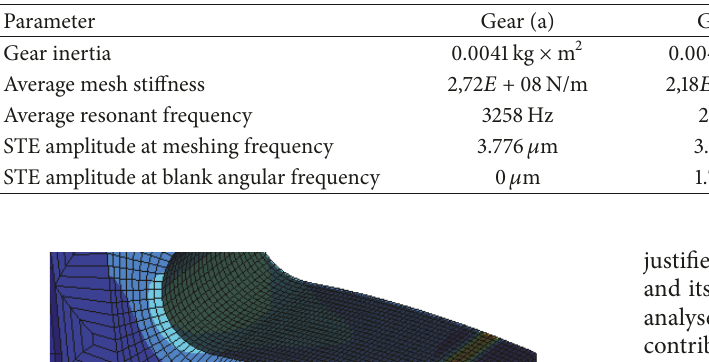
Table 2: Main properties of the gears that will be used in the analytical model for dynamic simulations.